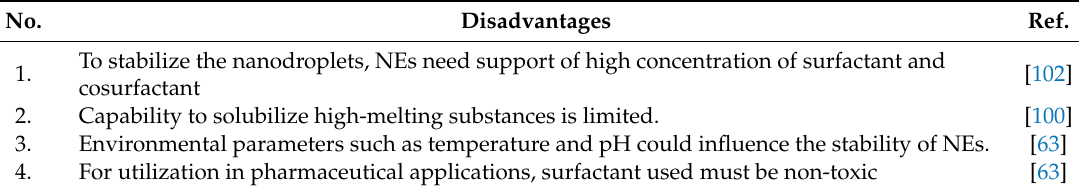
Table 5. Disadvantages of